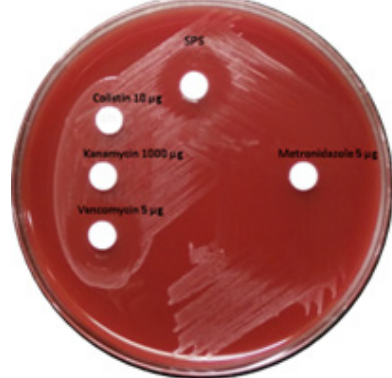
Fig. 1. Growth of P. anaerobius on 5% Sheep blood agar showing zone of inhibition around Vancomycin 5µg and 5% Sodium Polyanethol Sulfonate (SPS) Table 2. Clinical Laboratory Standards Institute (CLSI) interpretive values for anaerobic bacterial pathogens